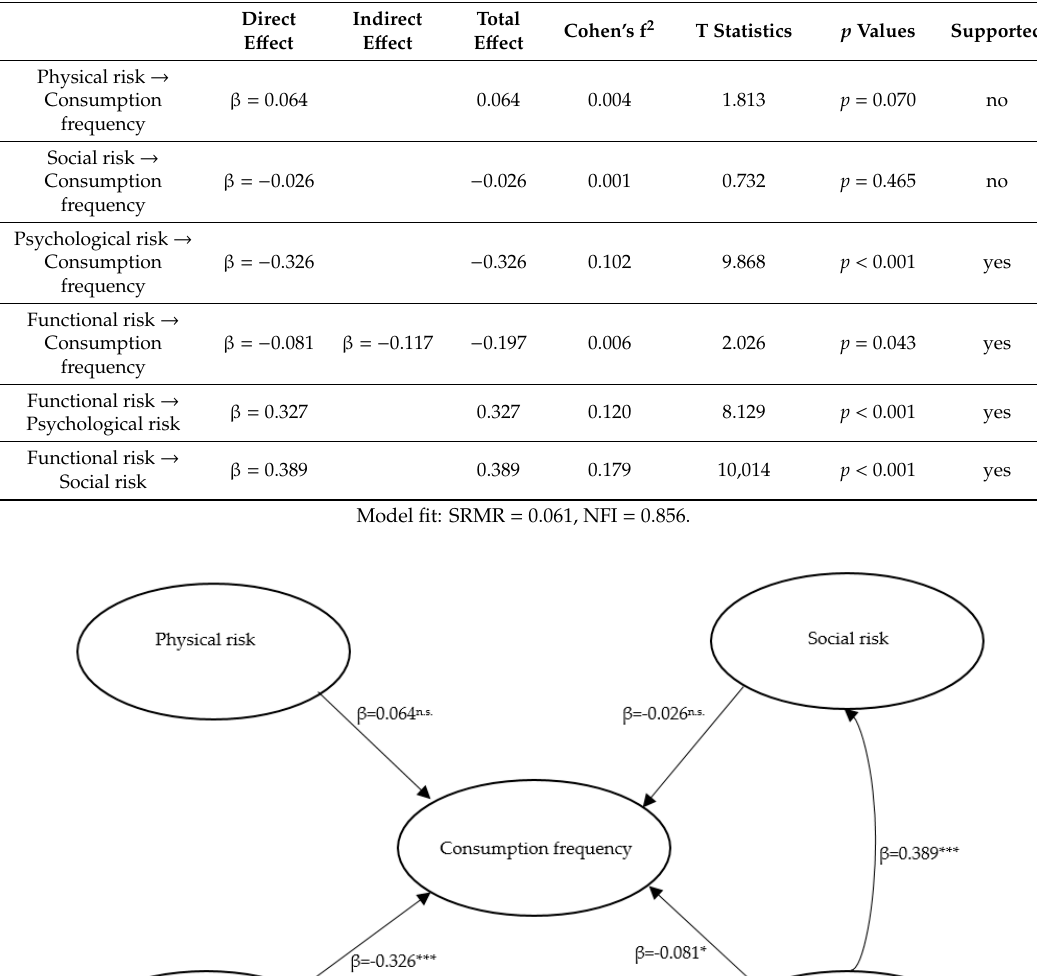
Table 7. Results for structural equation modelling.